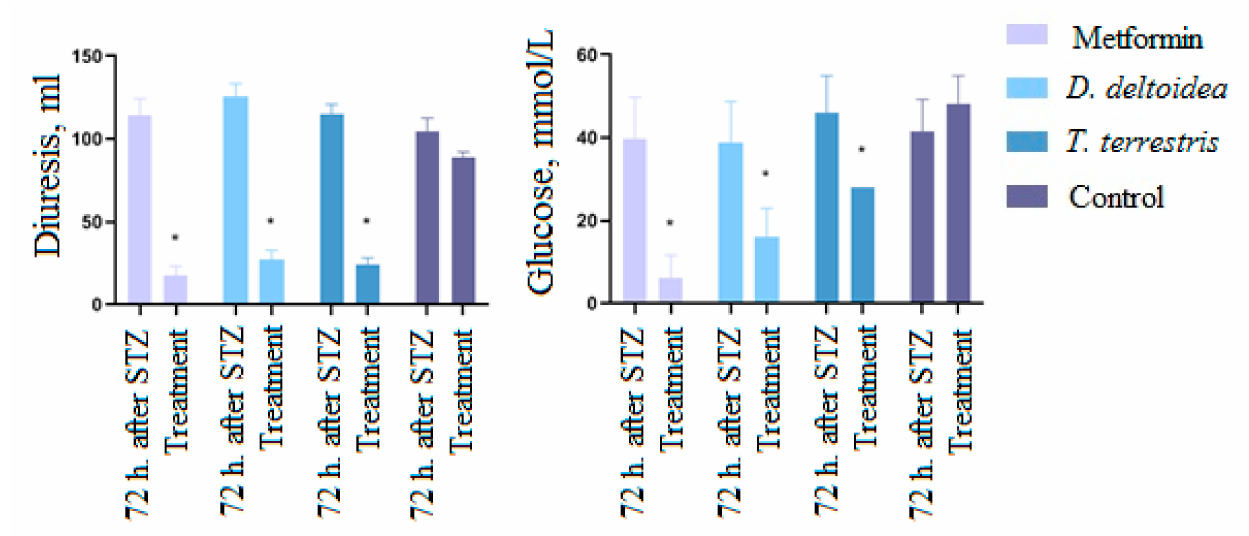
Figure 9. Change of diuresis and glucose level in urea after treatment with metformin and phytopreparations. * Significantly to the period after administration of